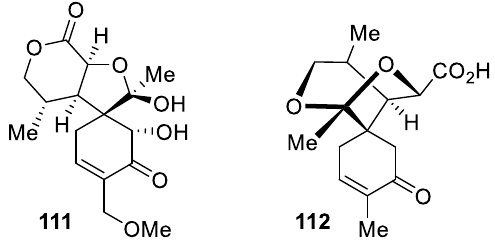
Figure 48. Spirocyclic carane lactones with insect-feeding deterrent activity.